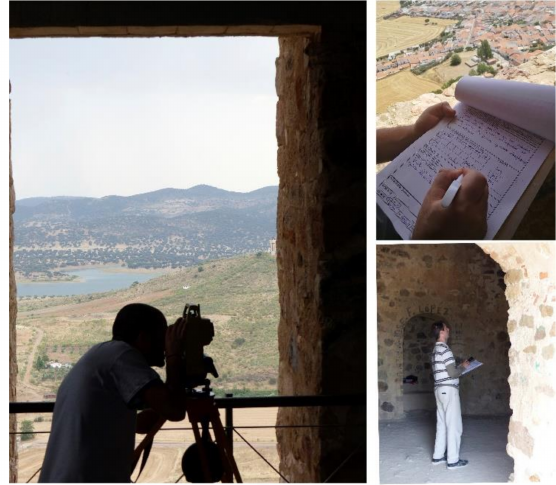
Figure 5. Geomatics acquisitions and documentation of temporal relationships in Belmez Castle. Copyright “Ager Mellariensis” / AEI FEDER HAR